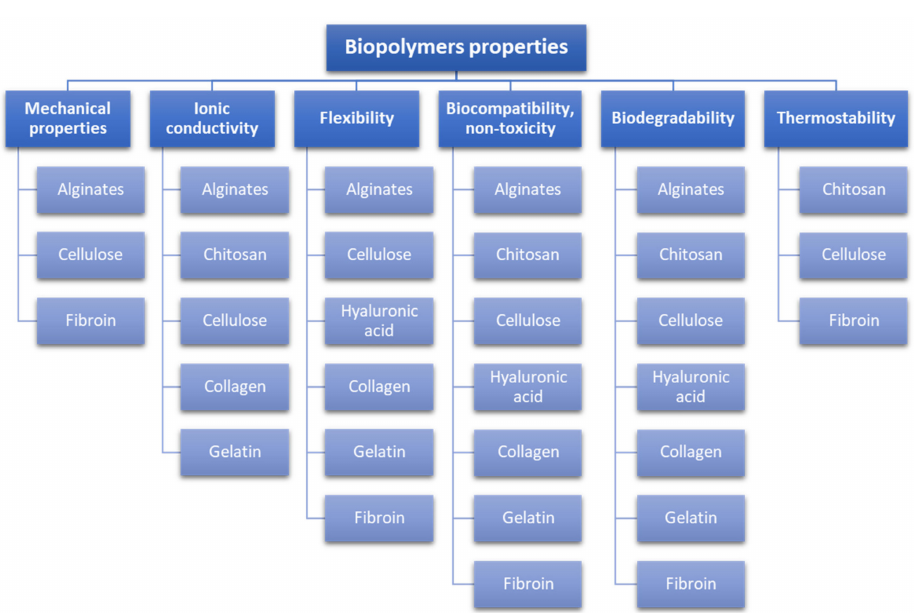
Figure 3. Selected properties of natural